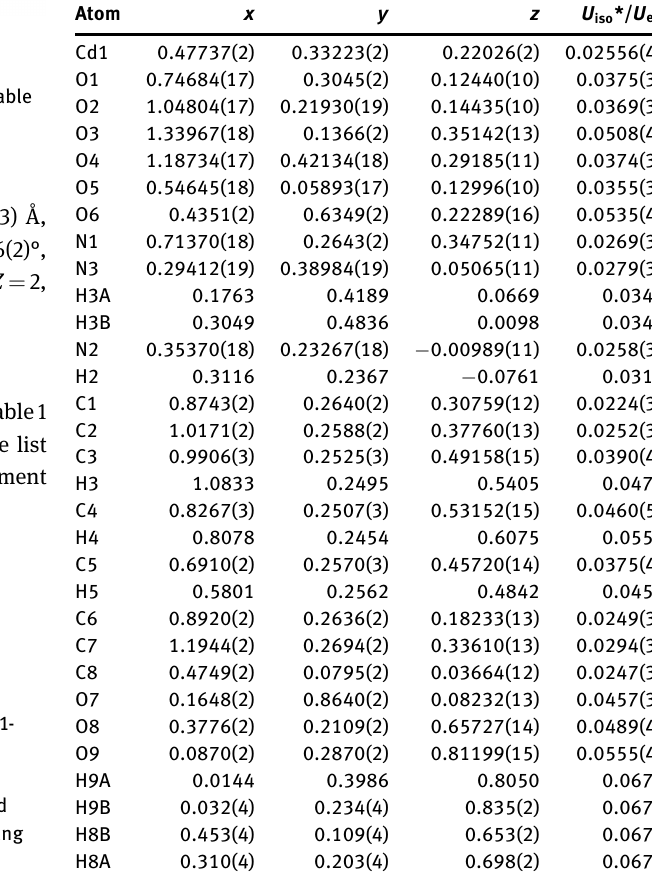
Table 2: Fractional atomic coordinates and isotropic or equivalent isotropic displacement parameters (Å 2